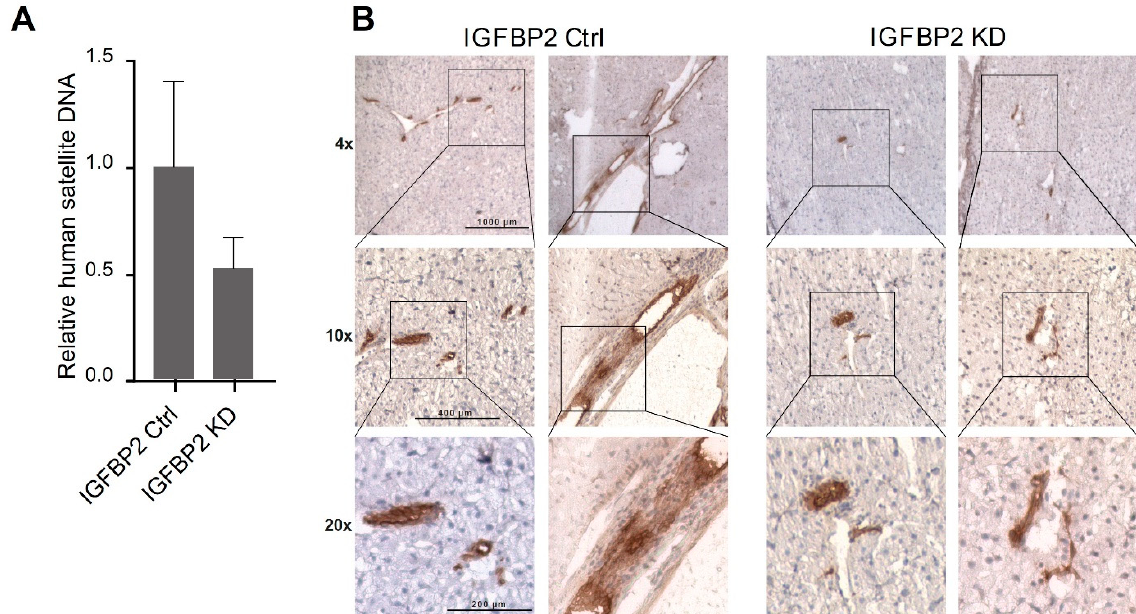
Figure 6 . IGFBP2 is the metastatic factor in vivo. After xenotransplantation of SW620 control or SW620 IGFBP2 KD cells, metastasis formation was inhibited by IGFBP2 knockdown, as shown by ( A ) human satellite DNA and ( B ) immunohisto- chemistry staining of human cytokeratin 19.